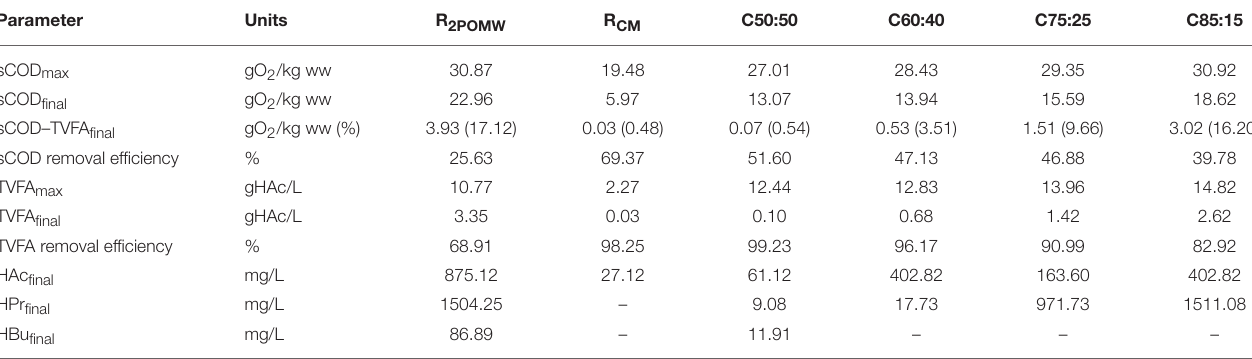
TABLE 3 | Performance data and maximum/final soluble organic matter (as sCODs, TVFA, and VFA composition) for 2POMW, CM and co-digestion mixtures. Parameter